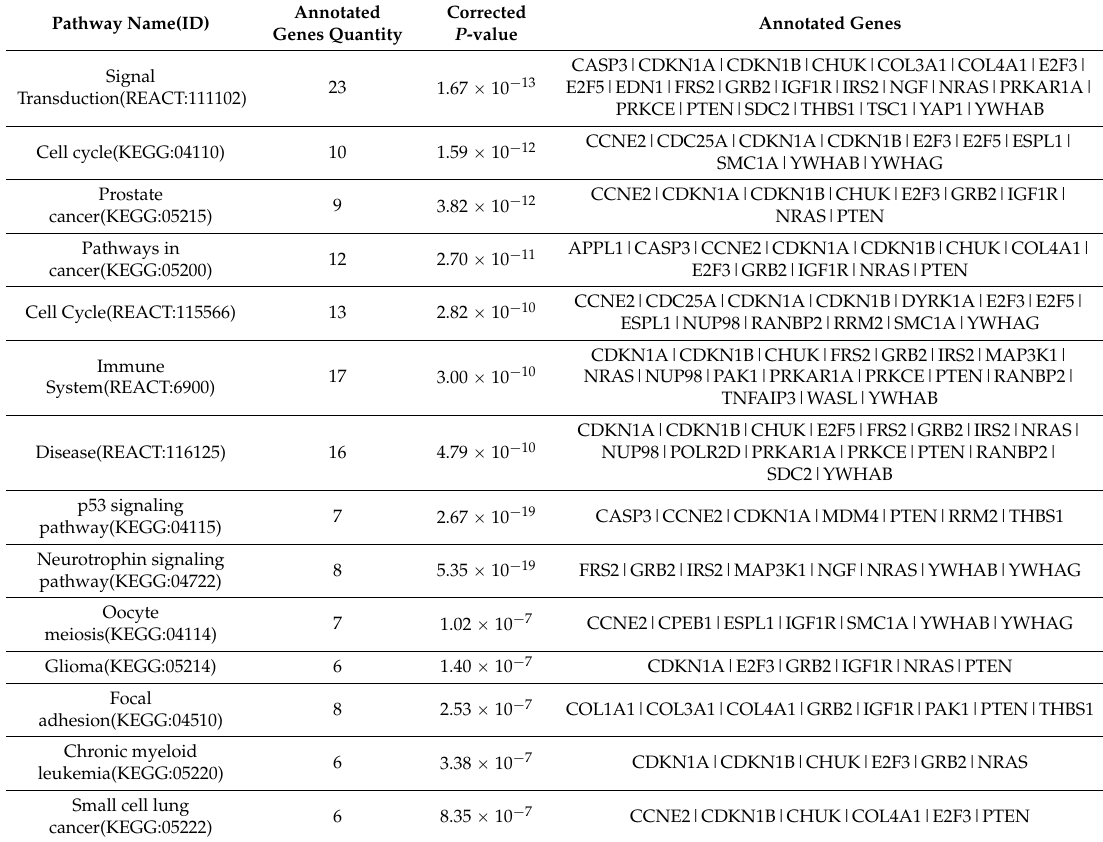
Table 1. Pathway analysis of top 61 protein-protein interaction (PPI)